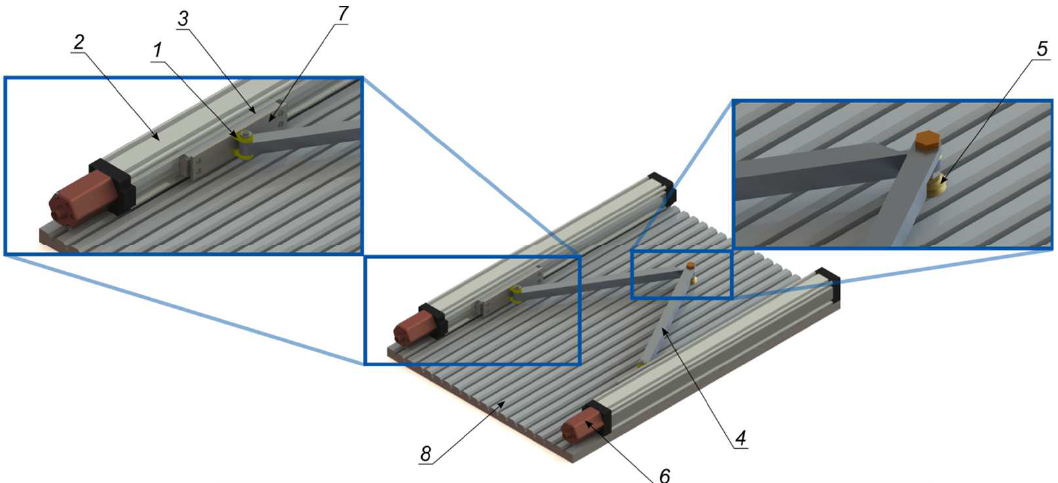
Figure 1. A solid model of a parallel manipulator: 1—bearing, 2—actuators, 3—actuator sliders, 4—arms, 5—end effector, 6—position transducers, 7—mounting plates, 8—baseplate.